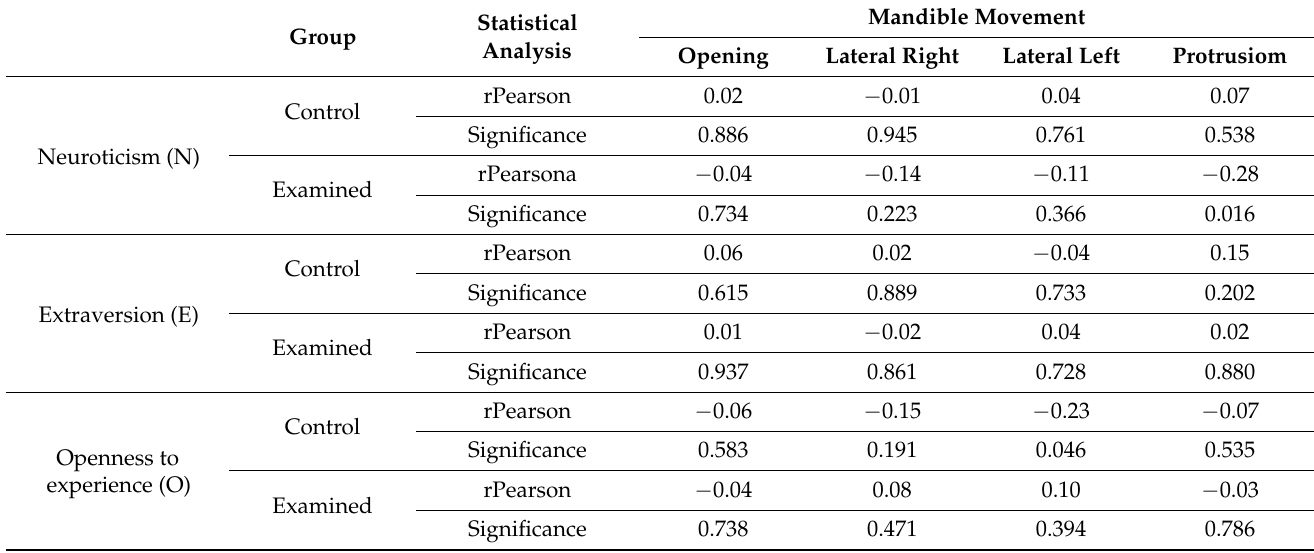
Table 7. Pearson’s r correlation coefficient for personality traits and ranges of mandibular movement in control and study